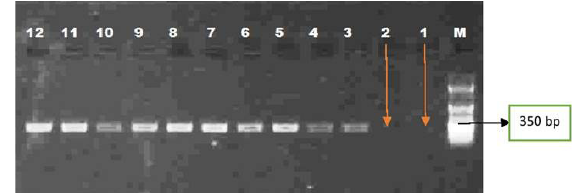
Fig. 7. Gel image of trnL-F primer amplified Inula gDNA’s by Phenol Choroform Isoamyl Alcohol Protocol 1. I. anatolica , 2.